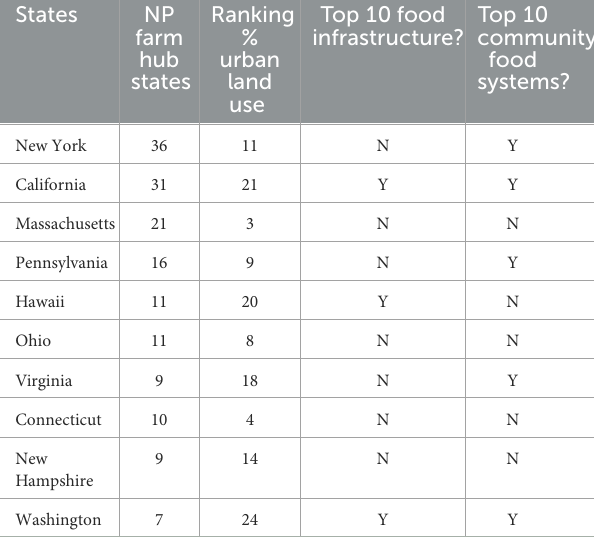
TABLE 3 States with high concentrations of non-profit farms compared to agricultural attributes. States NP